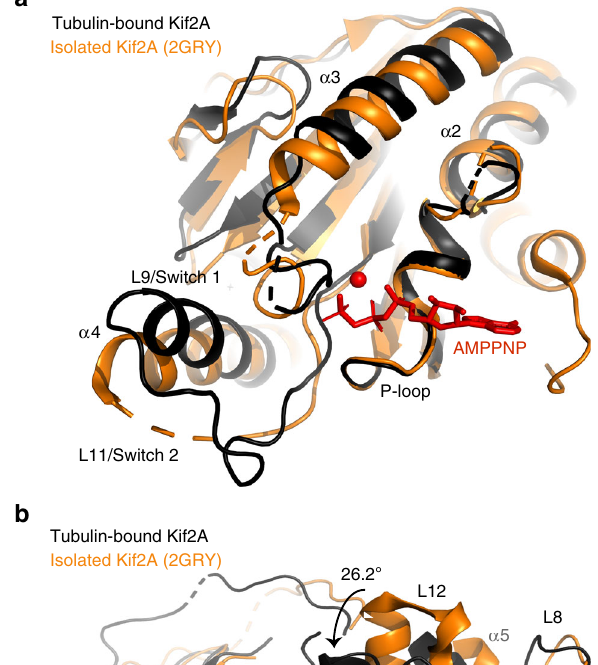
Fig. 4 Conformation of the Kif2A motor domain. a View of the nucleotide- binding pocket of tubulin-bound Kif2A (black) superimposed on isolated ADP-Kif2A (orange; PDB ID: 2GRY) via the P-loop. b View of the tubulin- binding surface. c Comparison of the α 4 helix orientation in the tubulin- bound Kif2A (black) and tubulin-bound Kin-1 (PDB ID: 4HNA, gray). Tubulin is represented in cartoon